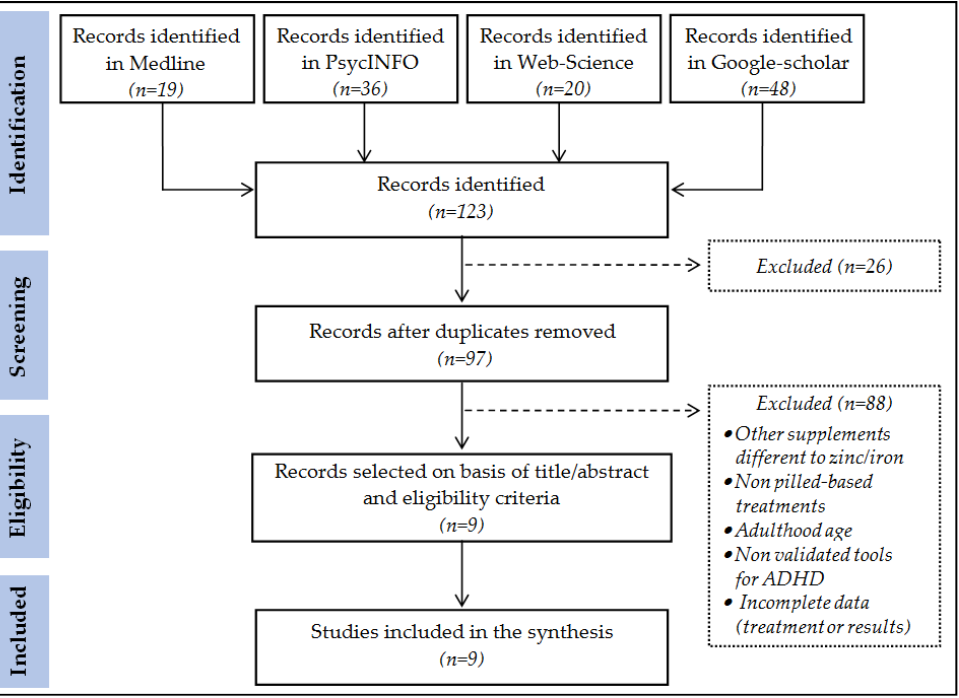
Figure 1. Search flow-chart.